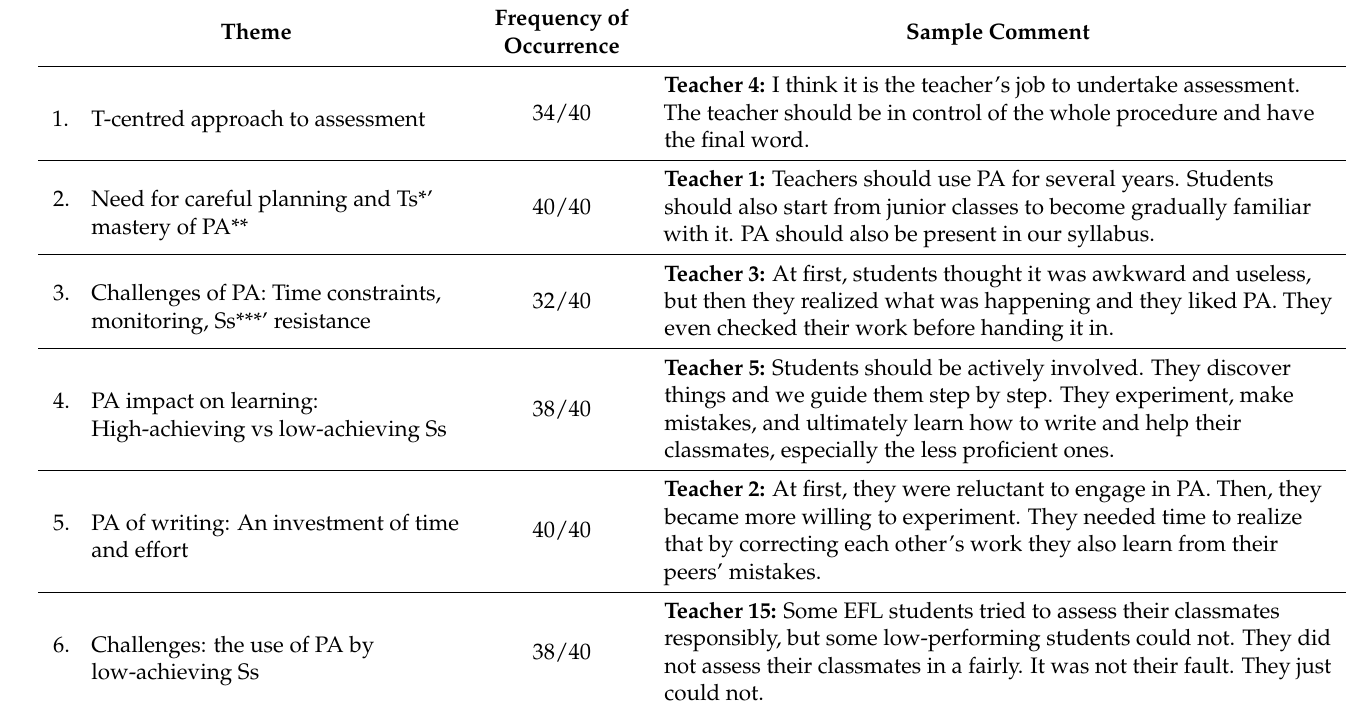
Table 2. Major themes emerging from the thematic